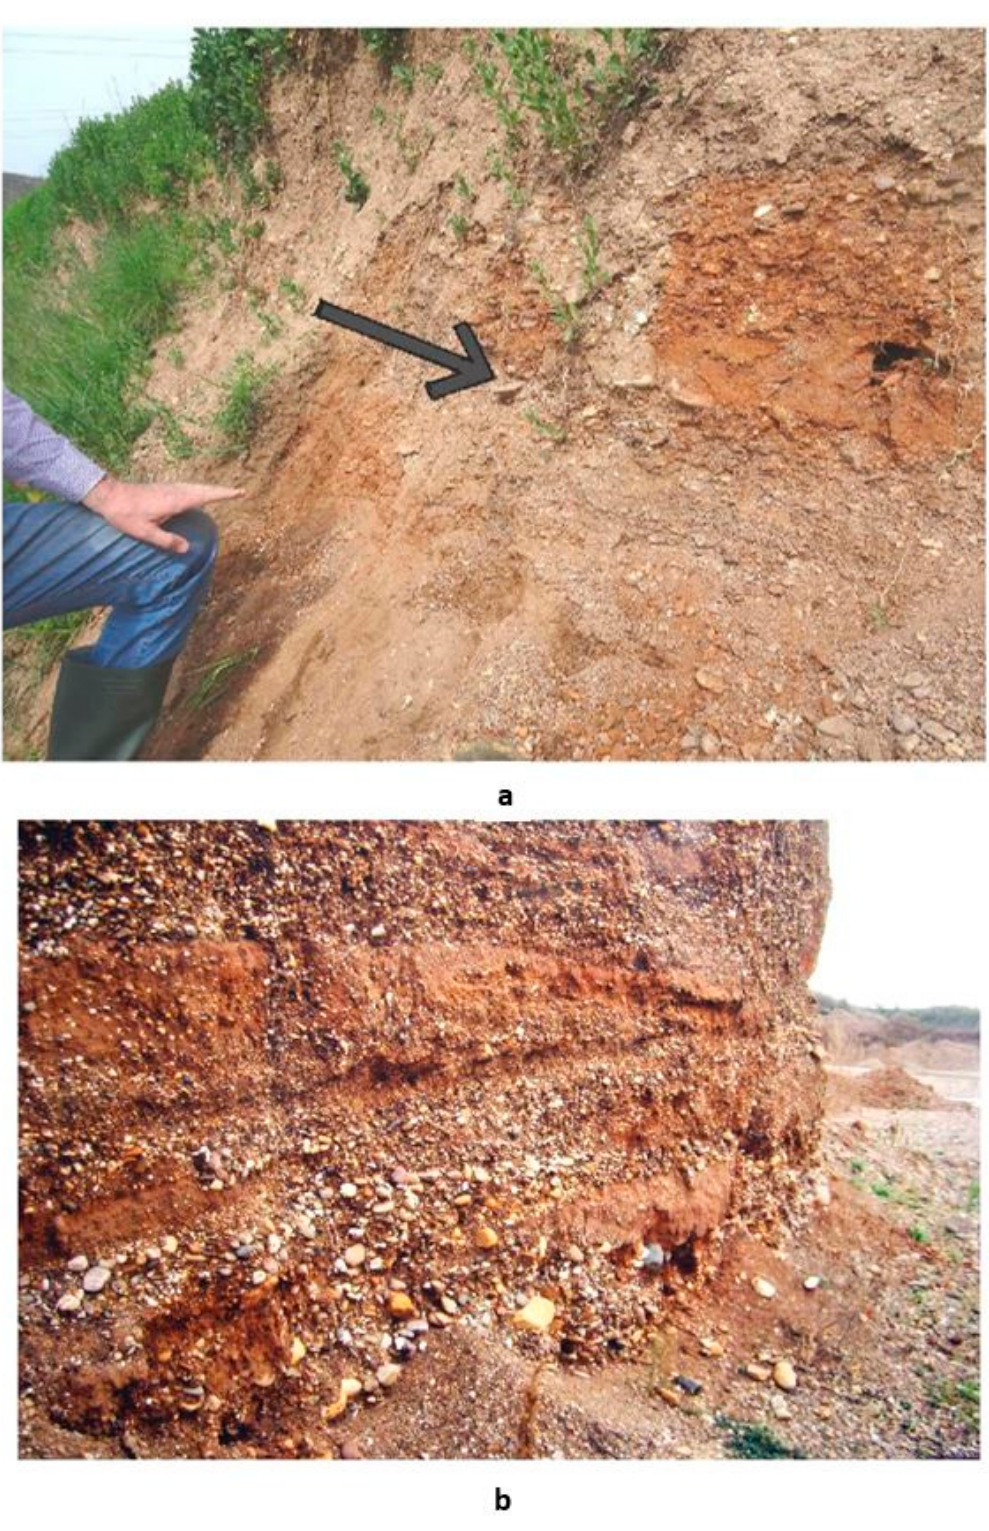
Figure 3. Münster-Sarmsheim. ( a ) Upper part of the terrace, Kombewa flake in situ; ( b ) the gravel pit at the Kesslers-Berg, about 125 m above the recent river level. The not exploited coarse gravel on the ground is bedded on sandstone bedrock. (Photos: 1.M. Stoll, 2. S. Stoll.).